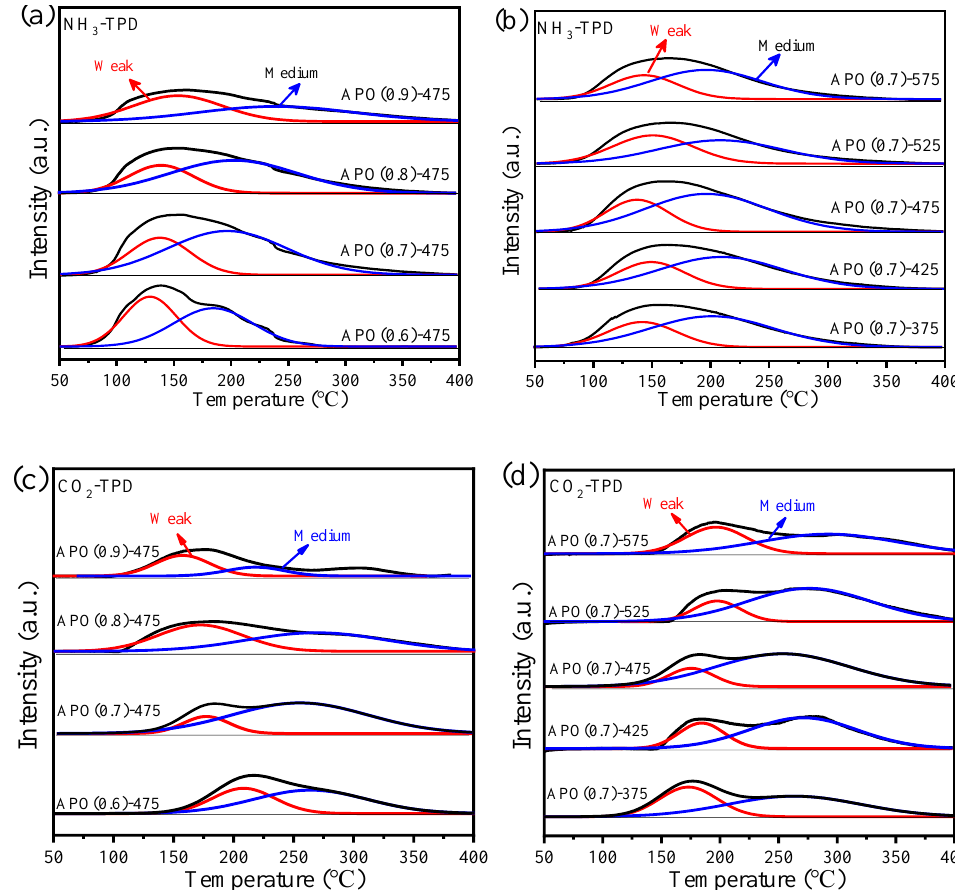
Figure 3. TPD profiles of ( a,b ) NH 3 -TPD and ( c,d ) CO 2 -TPD of APO catalysts with different P/Al ratios and calcination temperatures.